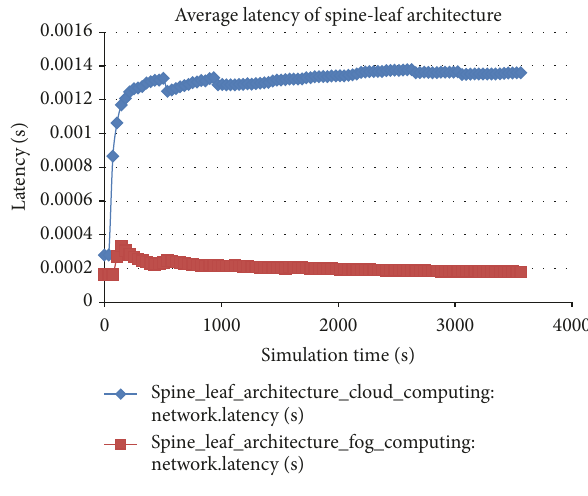
Figure 4: Average latency profile of SLFCN.